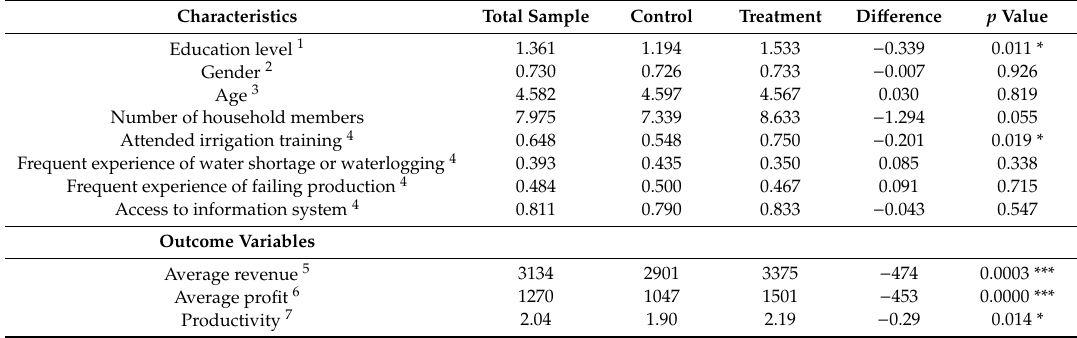
Table 3. Di ff erence in means of observable characteristics between treatment and control